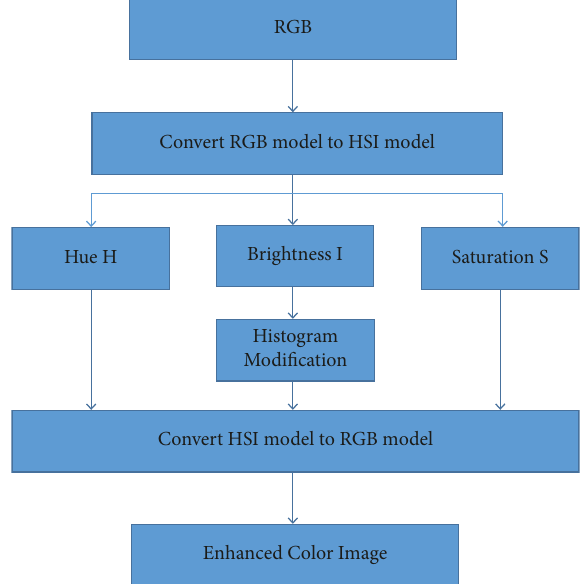
Figure 3: True color enhancement processing